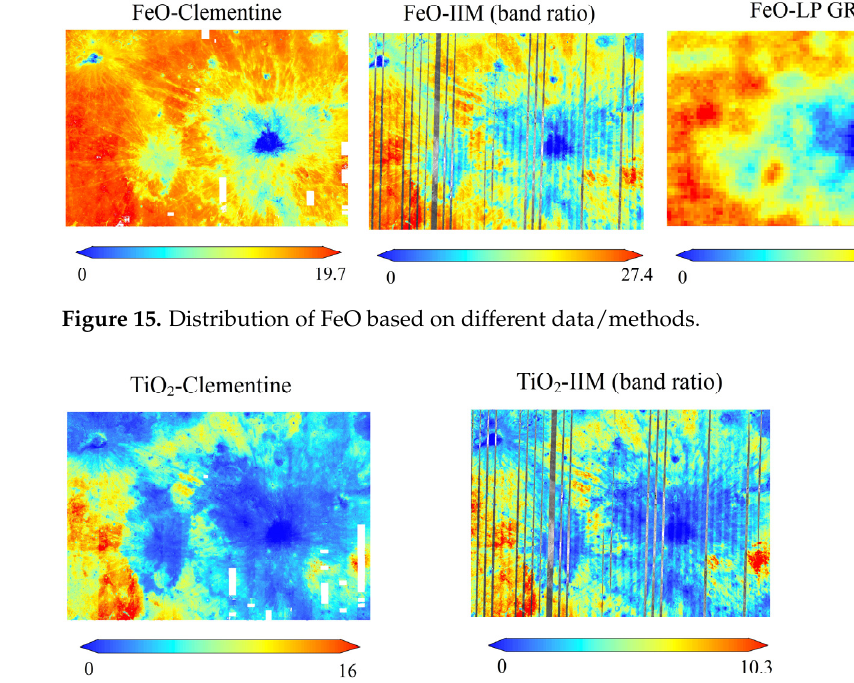
Figure 15. Distribution of FeO based on different data/methods. Table 5. Correlation coefficients based on different data/methods for FeO inversion.